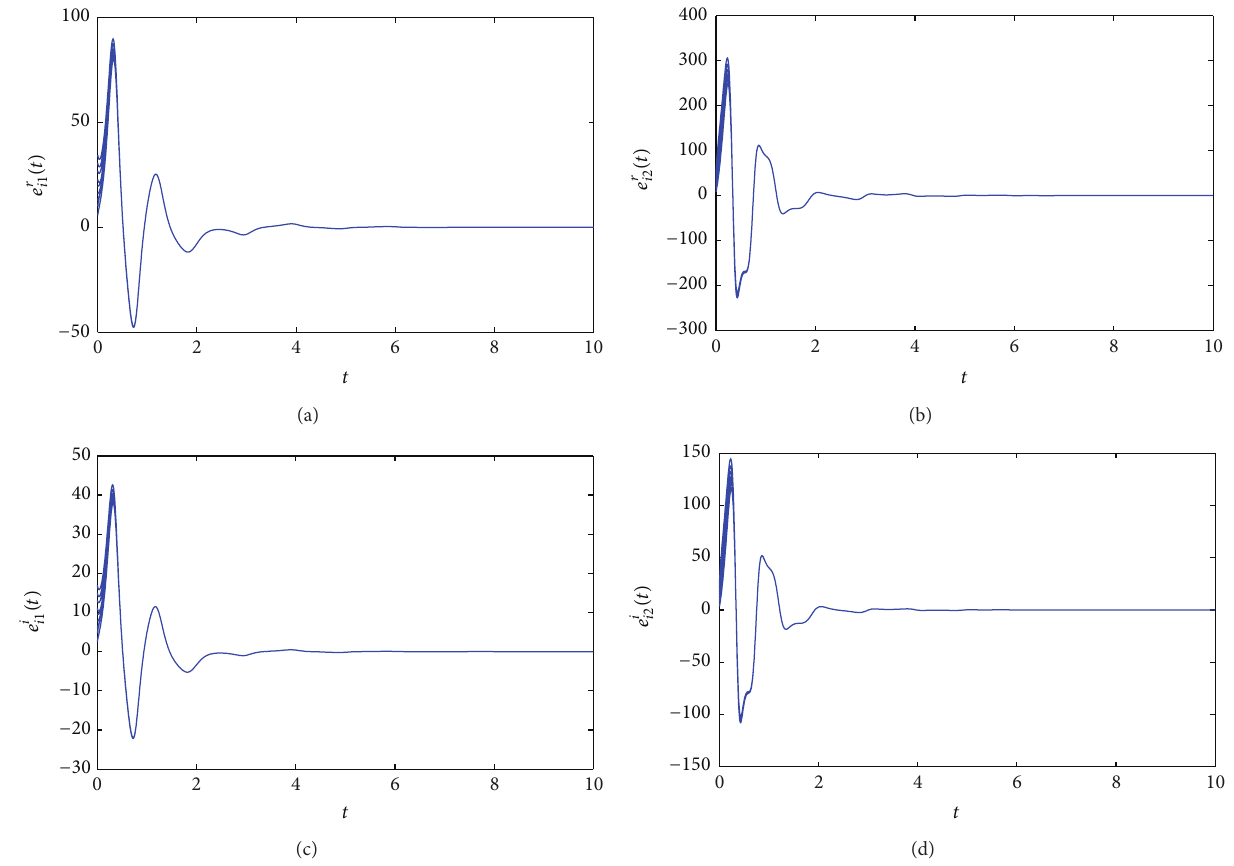
Figure 3: The evolution of the synchronization errors 𝑦 𝑖 (𝑖 = 1,2,...,10) by impulsive pinning